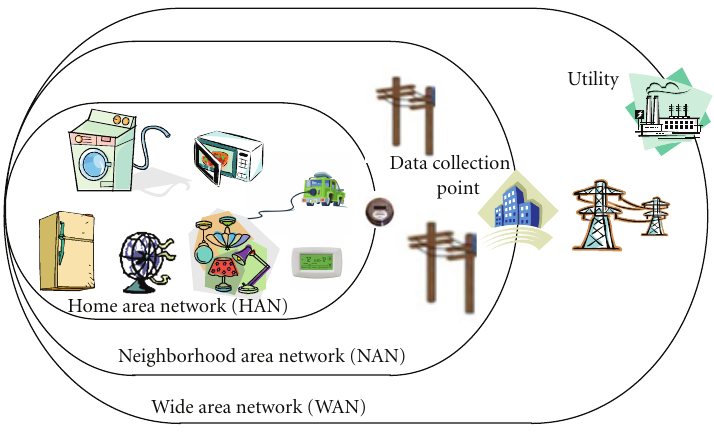
Figure 1: Integrating customer with smart